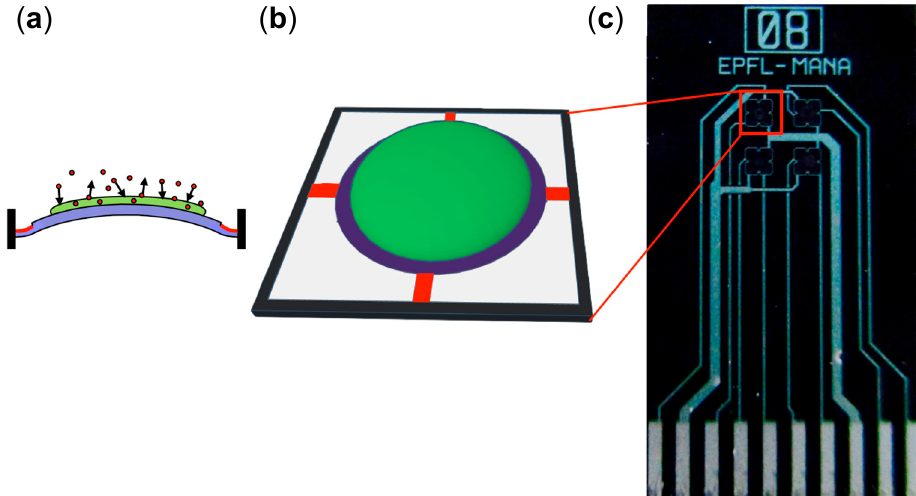
Figure 1. ( a ) Schematic illustration of the side view of the membrane. Blue, green, and red parts correspond to substrate, receptor layer, and embedded piezoresistors, respectively. ( b ) Schematic illustration of sensor channel. ( c ) Optical microscope image of a membrane-type surface stress sensor (MSS) chip.